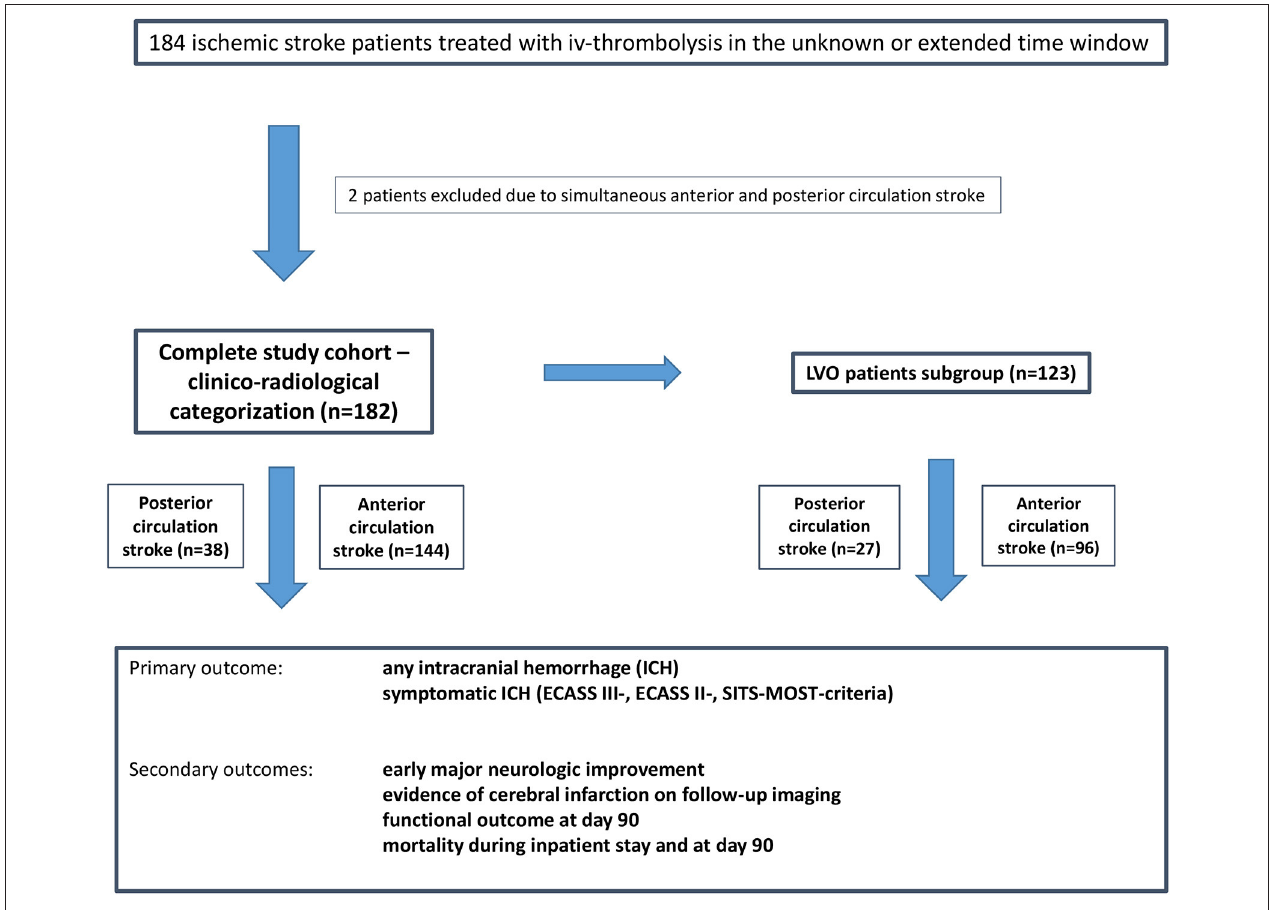
FIGURE 2 | Flow chart of the study